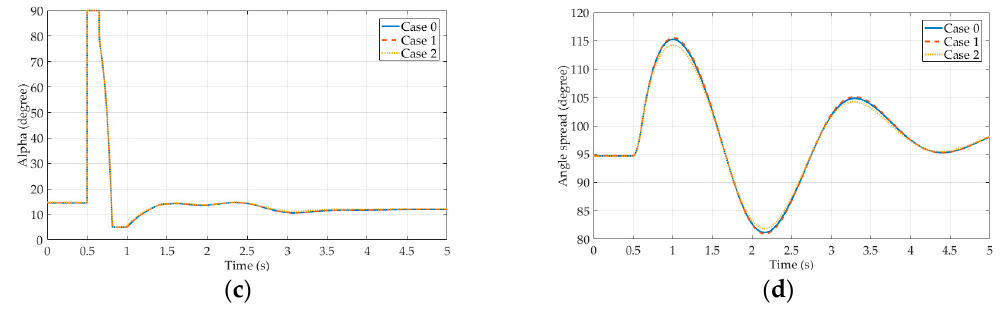
Figure 11. Existing HVDC in Korean power system performance from the transient stability simulation: ( a ) active power transmission; ( b ) DC voltage of rectifier; ( c ) alpha angle; and ( d ) angle spread of AC system.